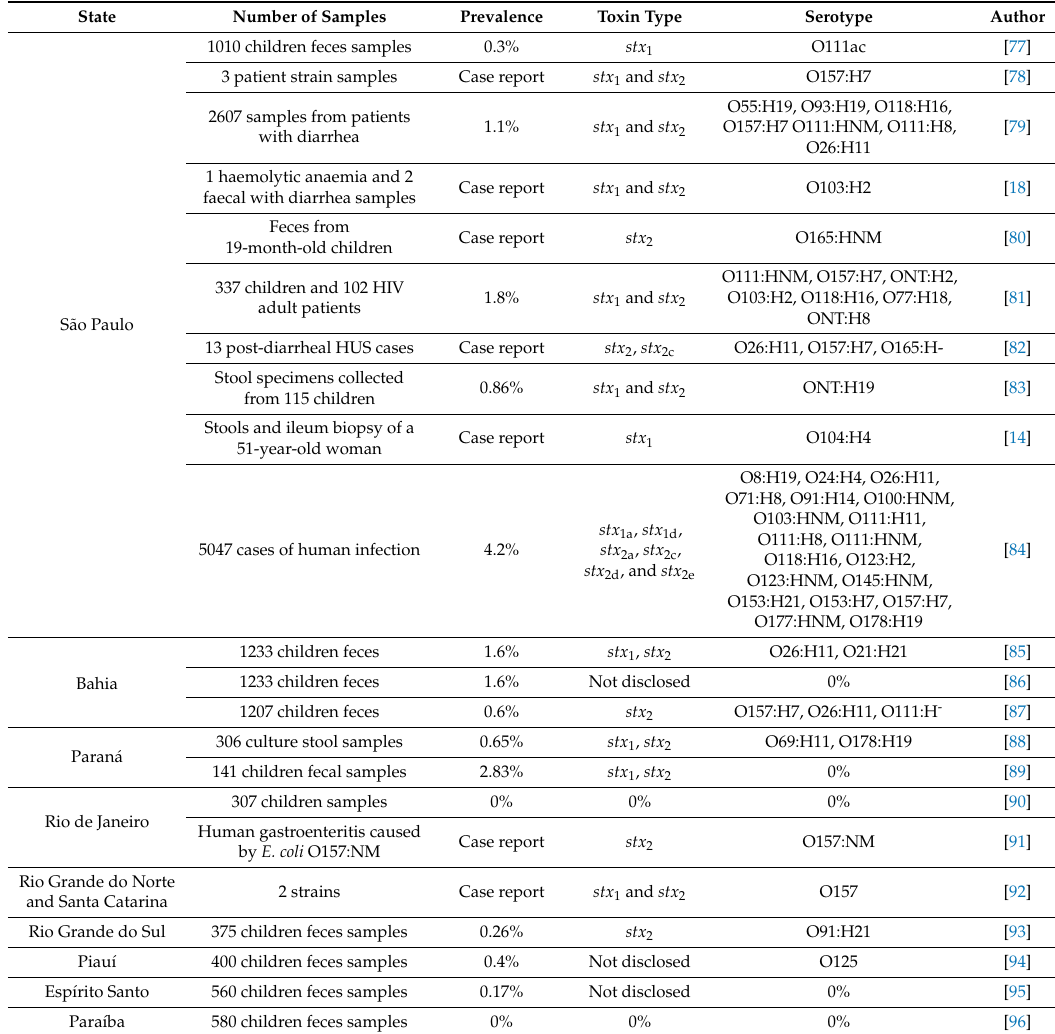
Table 3. Prevalence of Shiga toxin-producing Escherichia coli isolated in cases of foodborne disease in